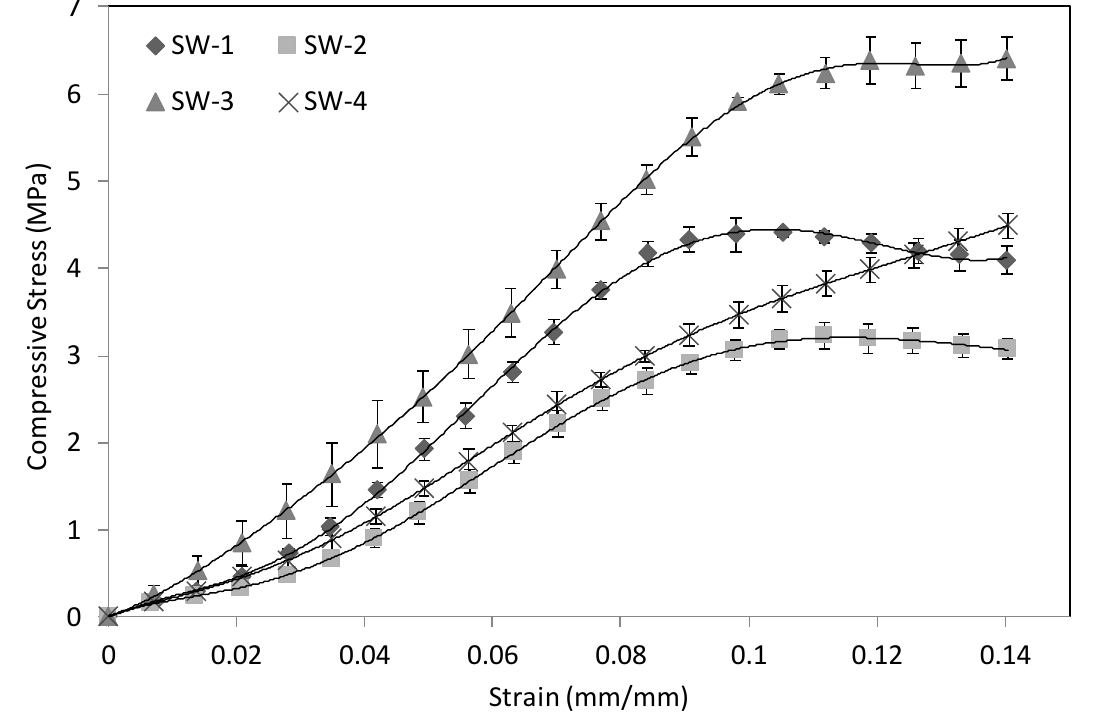
Figure 5. Flatwise compression stress–strain curves. Table 3. Compressive properties of sandwich